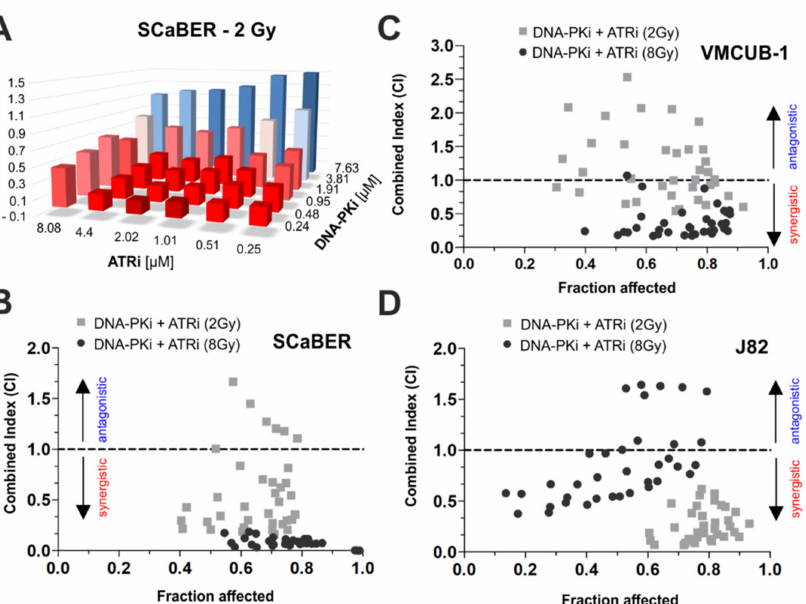
Figure 5. Dual ATR and DNA-PK inhibition mediates short-term synergistic effects depending on radiation dose and cellular background. The combination index (CI) was calculated in order to assess the combined effects of drugs (CompuSyn software, v.1.0). ( A ) 3D graph illustrates CI results for combined application of dual DNA-PK and ATR inhibition upon low dose irradiation of SCaBER cells. Drugs were used at concentrations of 4 × IC 50 , 2 × IC 50 , 1 × IC 50 , 0.5 × IC 50 , 0.25 × IC 50 , 0.125 × IC 50 of each drug for SCaBER. CI = 1: additive effect, CI < 1: synergistic effect (red), CI > 1: antagonistic effect (blue). ( B – D ) Graphs illustrating CI results for cell fractions affected by dual application of DNA-PK and ATR inhibitors in combination with two distinct radiation doses (low 2 Gy and high 8 Gy) on SCaBER ( B ), VMCUB-1 ( C ) and J82 ( D ) cells after 72 h. CI data represents means from at least n = 3 independent